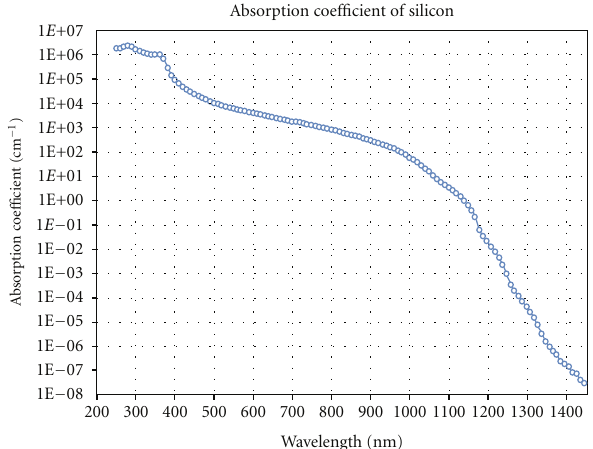
Figure 8: The absorption coe ffi cient of silicon in cm − 1 as a function of the wavelength. Silicon is an indirect bandgap semiconductor so there is a long tail in absorption out to long wavelengths. The data is graphed on a log scale. The drop in absorption at the band gap edge (around 1100nm) is much more rapid than that might appear due to the use of a log scale